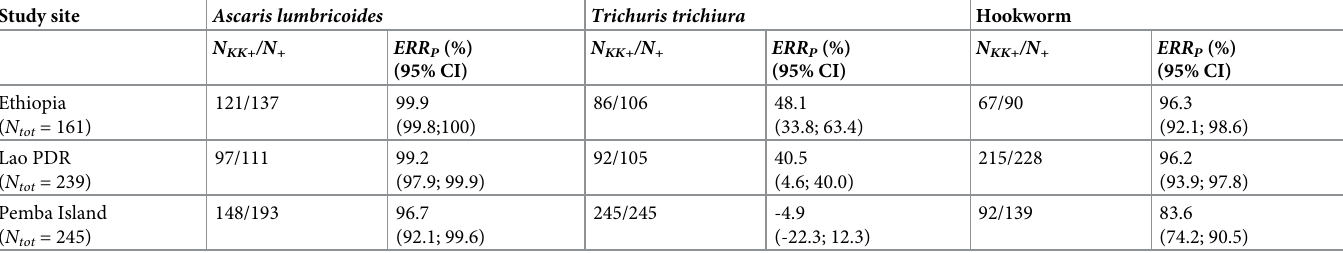
Table 1. Population-based therapeutic efficacy of albendazole against soil-transmitted helminth infections in three study sites. The population-based therapeutic efficacy is expressed as the egg reduction rate, ERR P , defined as the reduction in the arithmetic mean fecal egg count (FEC) following administration of a single 400 mg oral dose of albendazole (see Eq (1) ). The FECs were based on duplicate Kato-Katz thick smear. N represents the total number of participants screened for STH infection; tot N + the number of participants identified as infected at baseline by any of the four diagnostics (duplicate Kato-Katz thick smear, Mini-FLOTAC, FECPAK G2 and qPCR) and, N the number of participants infected at baseline by duplicate Kato-Katz thick smear. The 95% confidence intervals (CIs) were calculated using a non-parametric KK+ block bootstrap approach